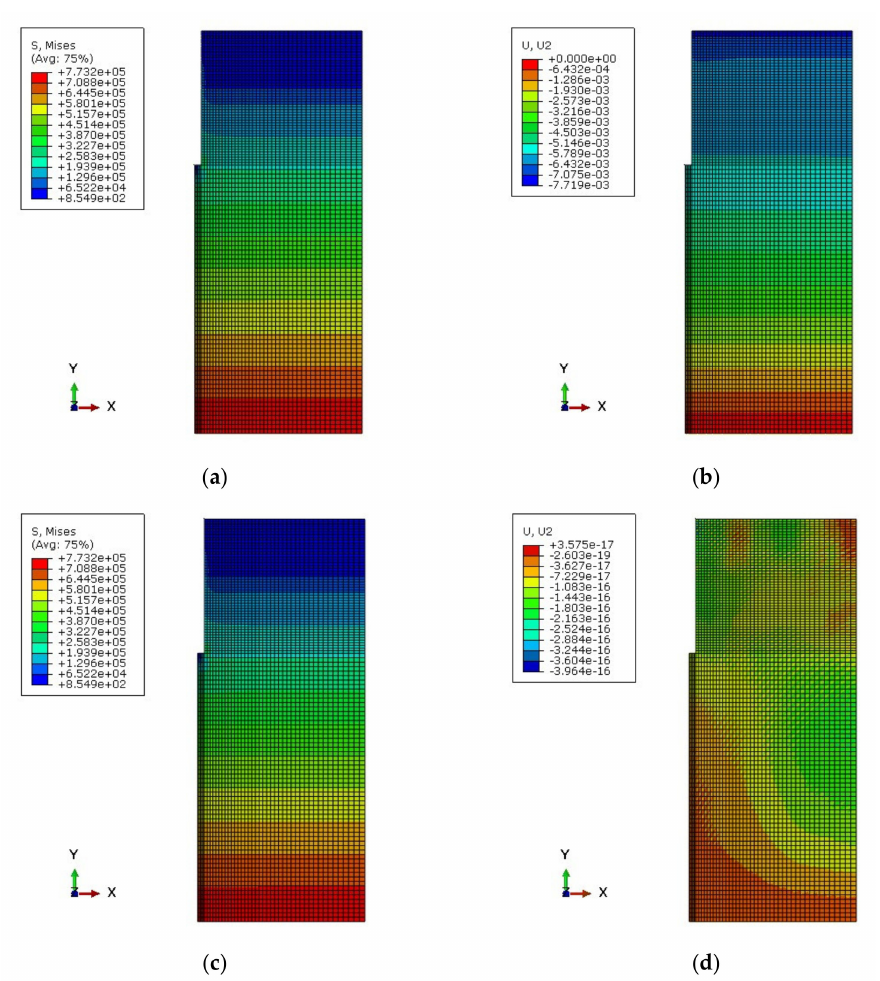
Figure 7. ( a ) The stress distribution before the ground stress equilibrium; ( b ) the displacement distribution before the ground stress equilibrium; ( c ) the stress distribution after the ground stress equilibrium; ( d ) the displacement distribution after the ground stress